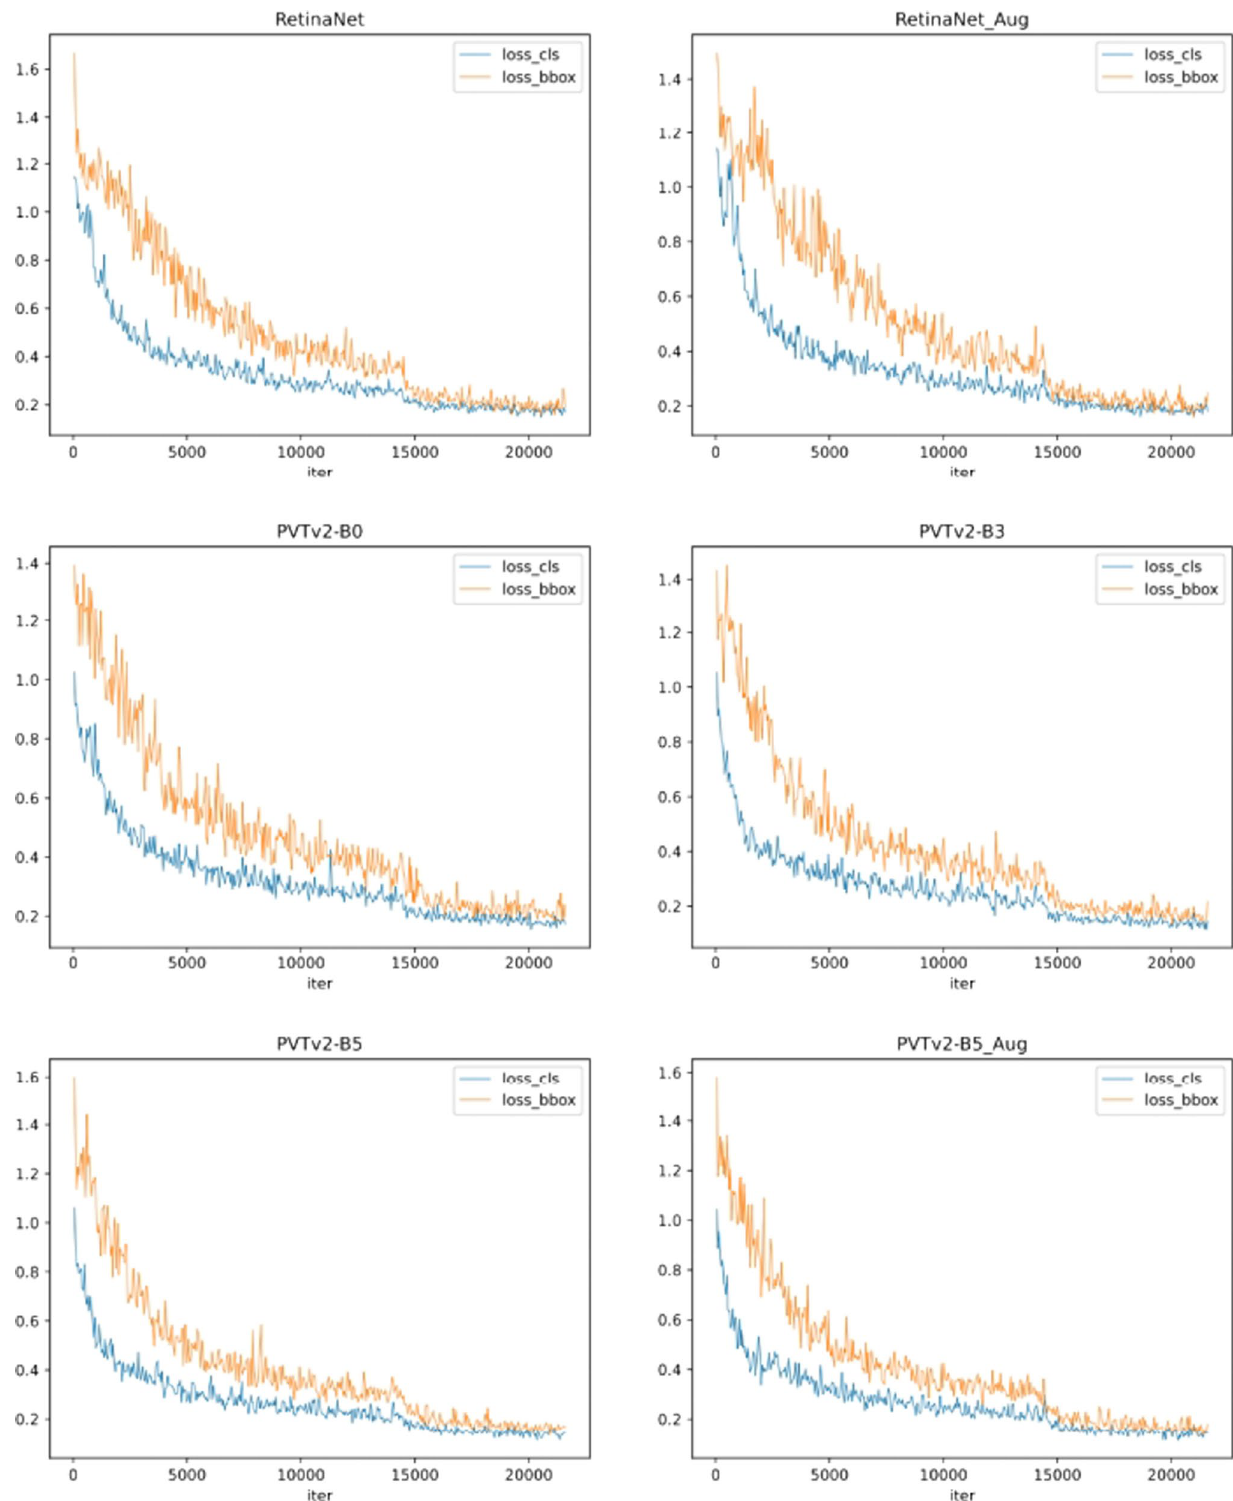
Fig. 5 Loss curve for ablation experiments on